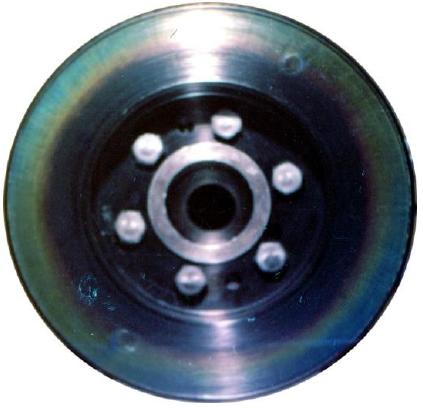
Figure 10. Damper temperature changes as a function of time for different shaft rotational speeds n i (n 1 < n 2 ).